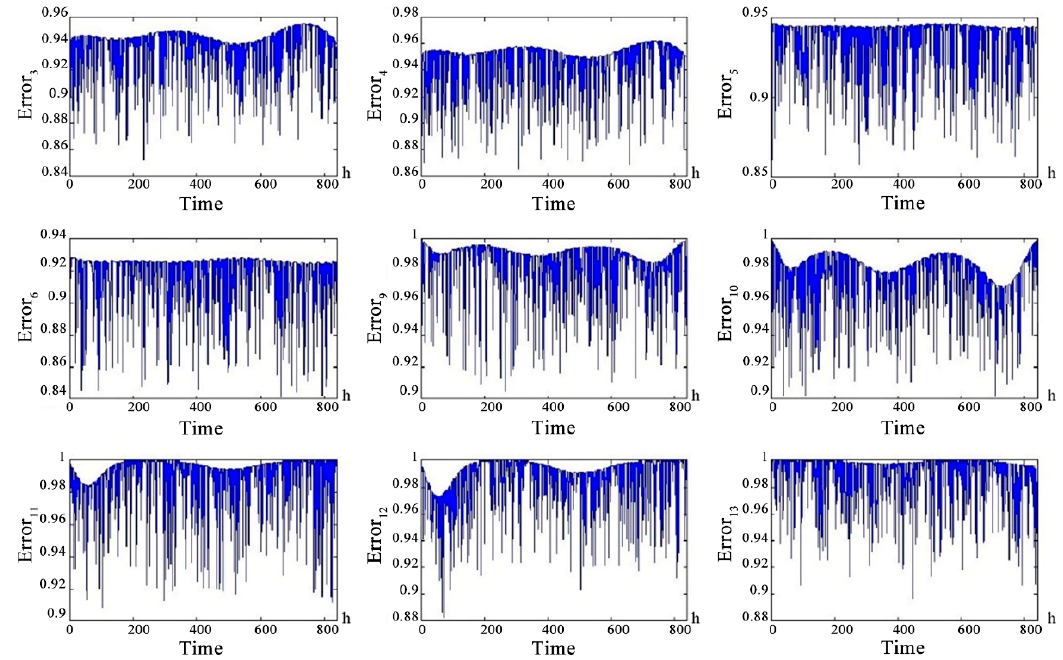
Figure 8. Communication distance distribution curve of each link of solar-powered UAV data-link system. ( a ) Communication distance of UAV-Satellite links; ( b ) Communication distance of ground-satellite links.